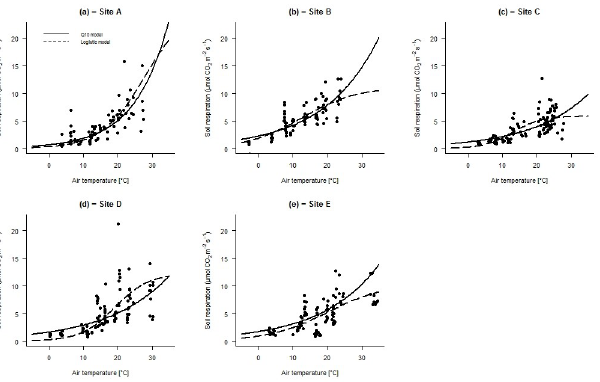
Fig 3. Rates of soil respiration against chamber air temperature in the different sites. Regression lines were built using the mean values of model parameters obtained for different replicate collars of each site (n = 10).